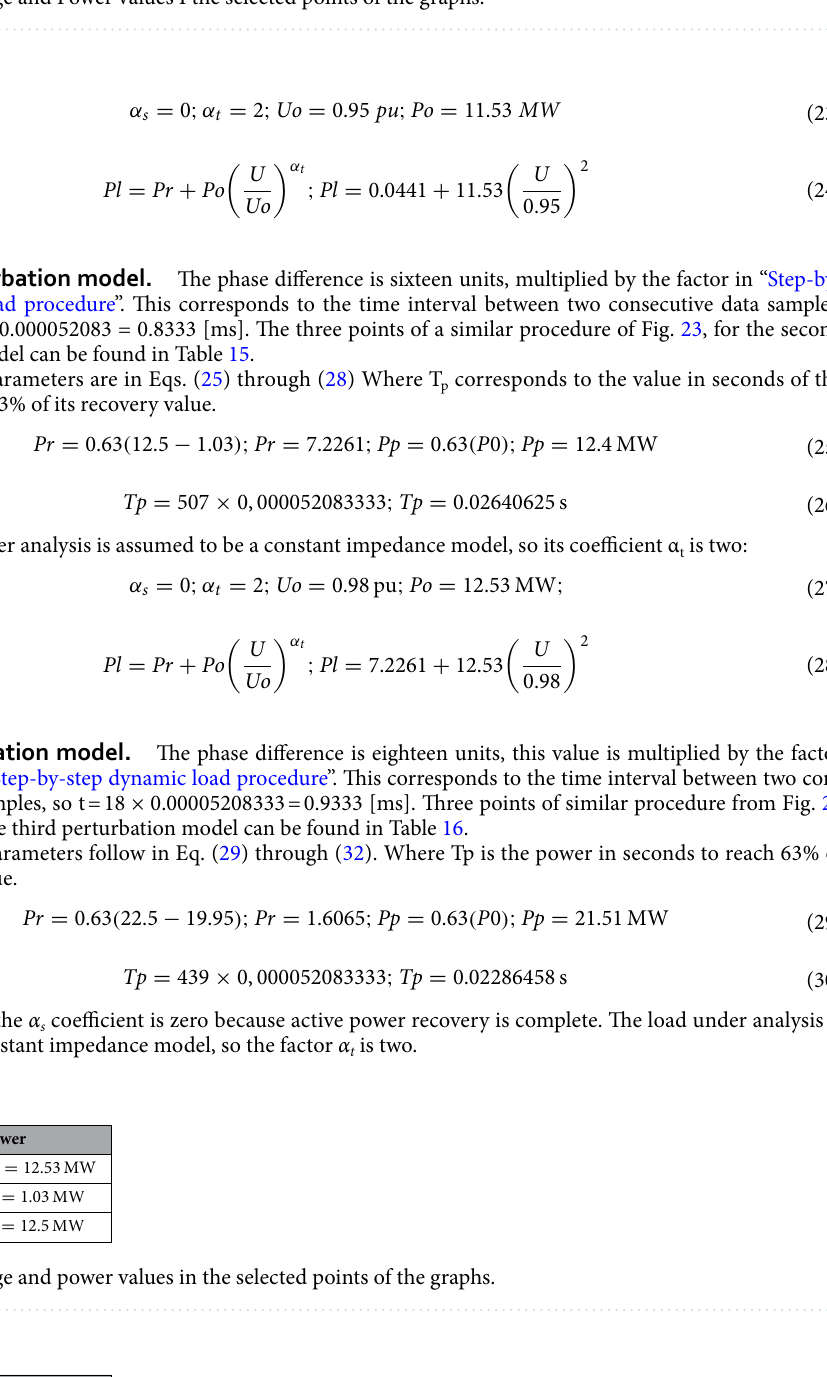
Table 14. Voltage and Power values I the selected points of the graphs.